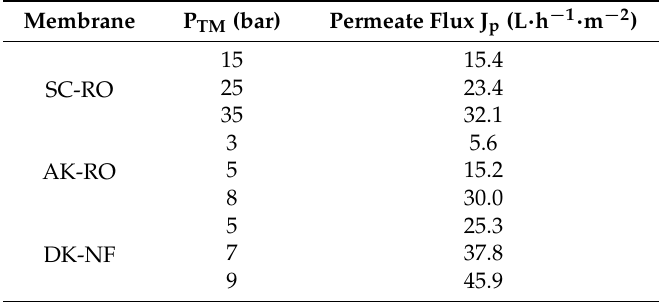
Table 5. Permeate flux (J p , L · h − 1 · m − 2 ) yielded by the used